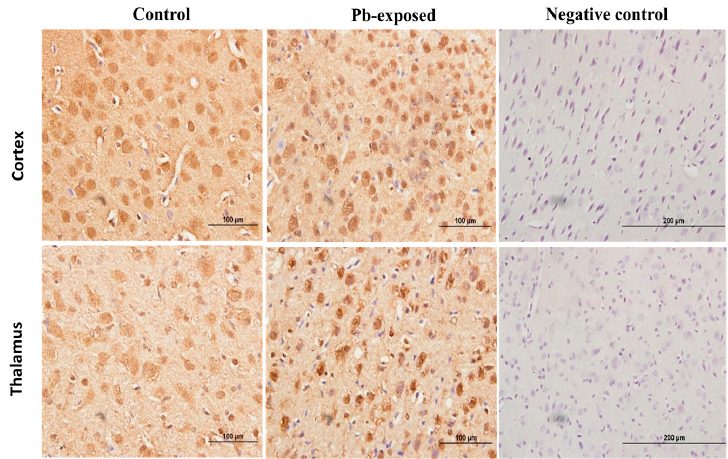
Figure 9. Immunohistochemistry photomicrographs showing the effect of Pb exposure on the expression of VDR in cerebrum of both control and Pb-exposed PND21 rats. Sections ( n = 3) were counterstained with Mayer’s hematoxylin. CR, cortex; TH, thalamus.